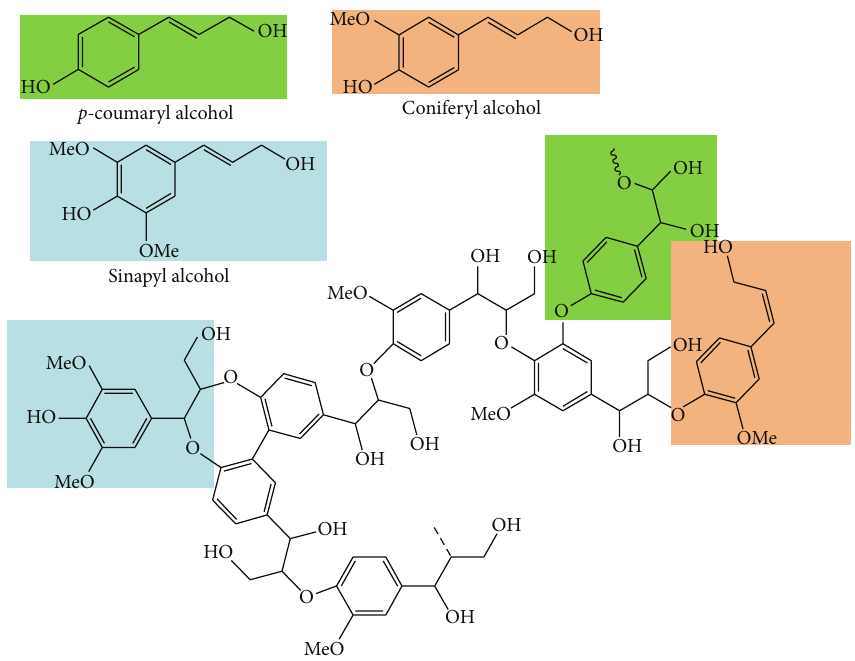
Figure 3: Chemical structures of lignin ( p -coumaryl alcohol, coniferyl alcohol, and sinapyl